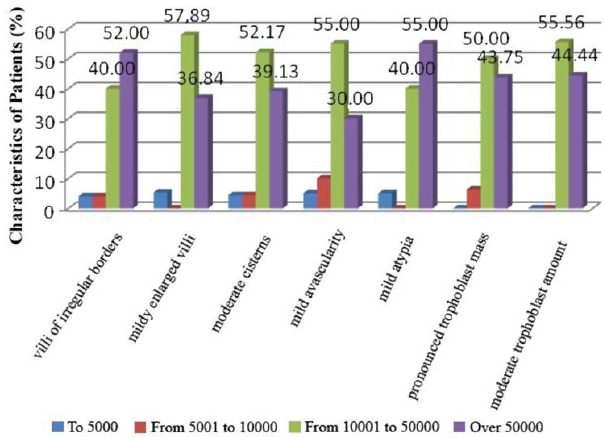
FIGURE 2. Relationship between the most signi fi cant pathomorphological changes and β HCG